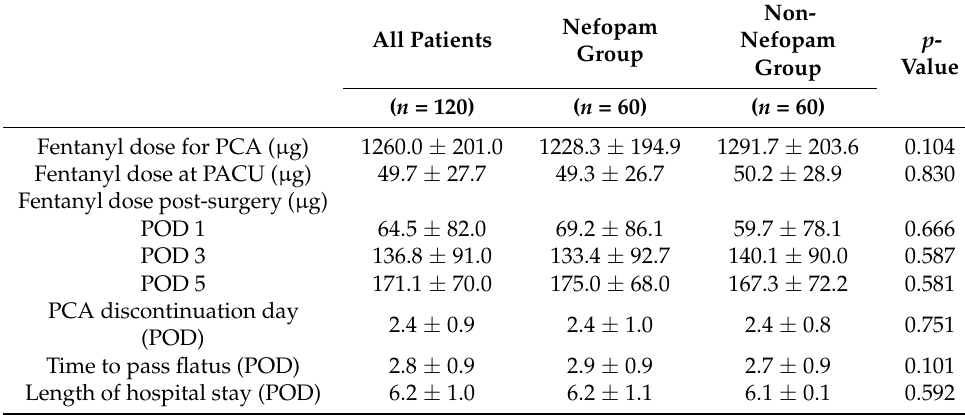
Table 4. Postoperative data.